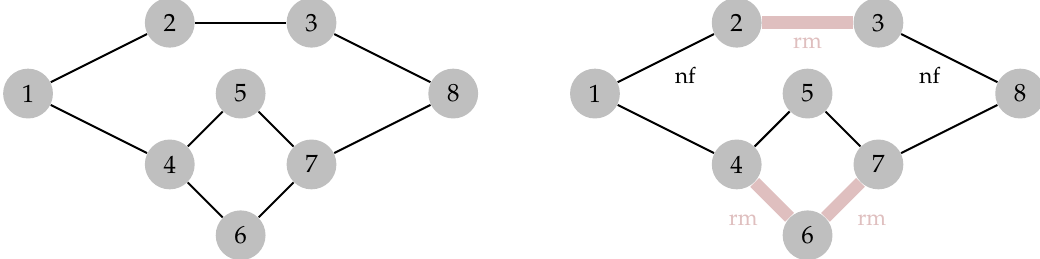
Figure 11. Scheme of network edges deletion from graph. ( left ) Normal network structure; ( right ) Randomly removed (rm) edges are marked in pink and non-functional ones are indicated as (nf).